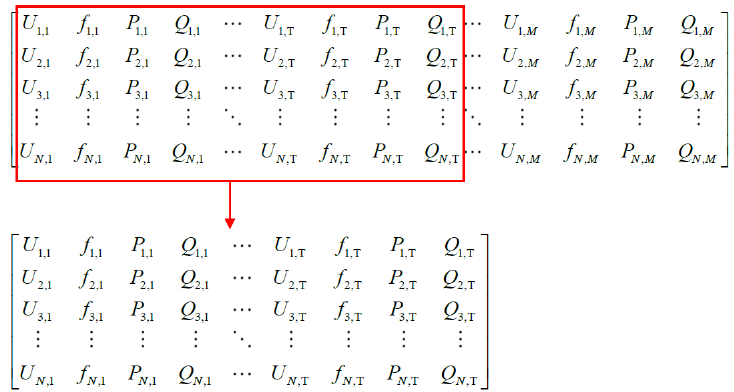
Figure 2. Data expansion mode in the case of unbalanced samples.